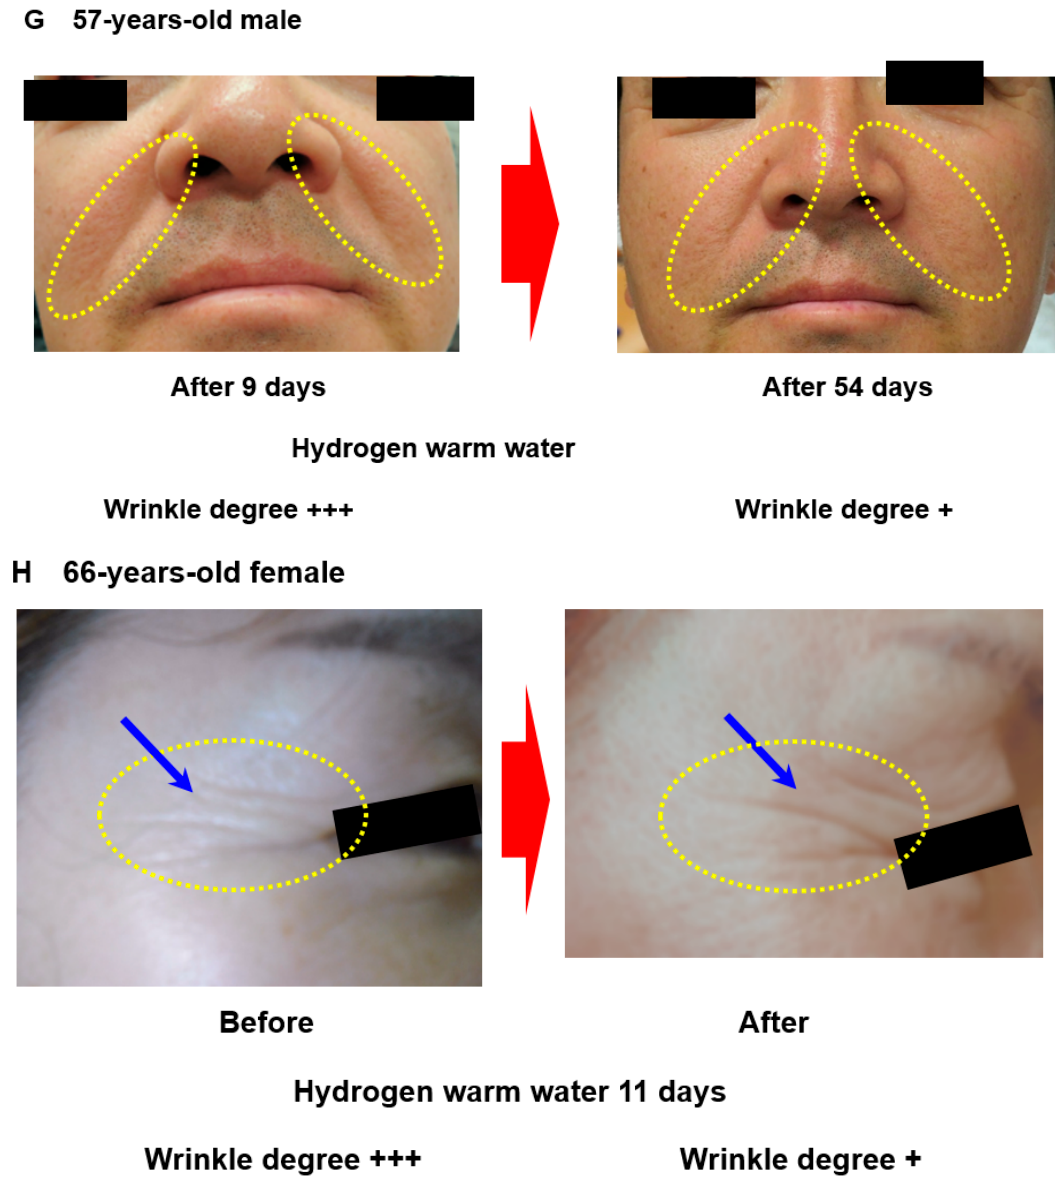
Figure 1. Improving effects on wrinkles of five subjects by 10 min bathing or repetitive three-time 3 min face poultice with hydrogen-rich warm water. Wrinkle degrees were sorted into seven hierarchies ( − , ±, +, ++, +++, ++++, +++++). ( A – C ): Reduction in small wrinkles around right-eye outer corner (indicated by a yellow dotted circle) was observed. ( D ): Reduction in wrinkles around forehead mole (indicated by a circle) was observed. ( E ): Reduction in wrinkles at left cheek (indicated by circles) was observed. ( F ): Reduction in wrinkles between the eyebrows (indicated by circles) was observed. ( G ): Improvement of wrinkles of both nasolabial folds (indicated by circles) was observed. ( H ): Before hydrogen application, among 4 wrinkles on the outer corners of the right eye (indicated by circles), the second wrinkle (indicated by an arrow) from the top was shallow and thin. However, the second wrinkle had almost disappeared, and the other three wrinkles had also become shallower and shorter.